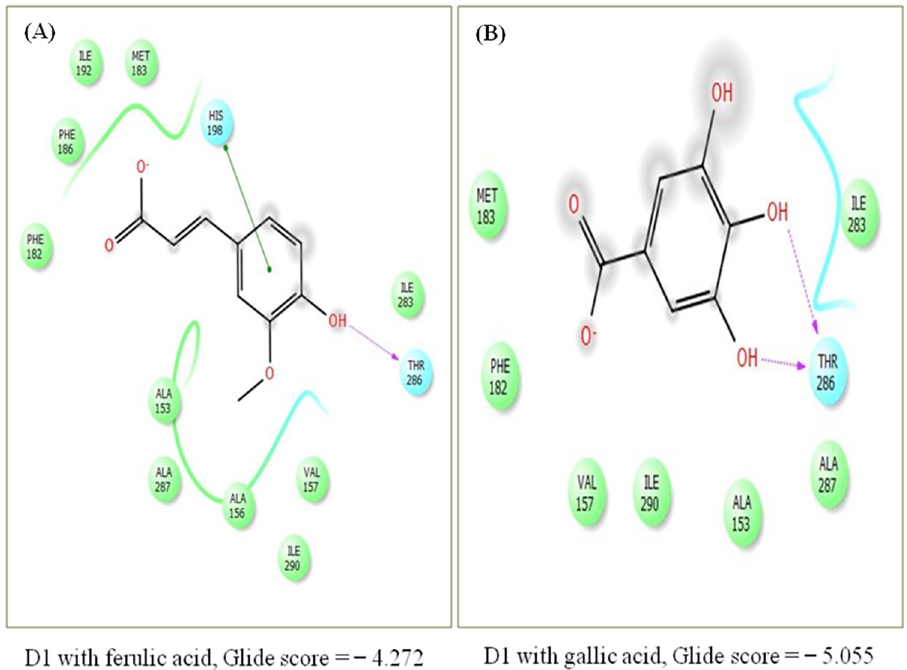
Fig 6. Target binding sites in photosynthetic protein (D1) as identified by molecular docking analysis. (A) docking with ferulic acid (FA), glide score = − 4.272; (B) docking with gallic acid (GA), glide score = − 5.055. Images were generated with PyMol. Higher binding affinity was shown by FA in comparison to GA.